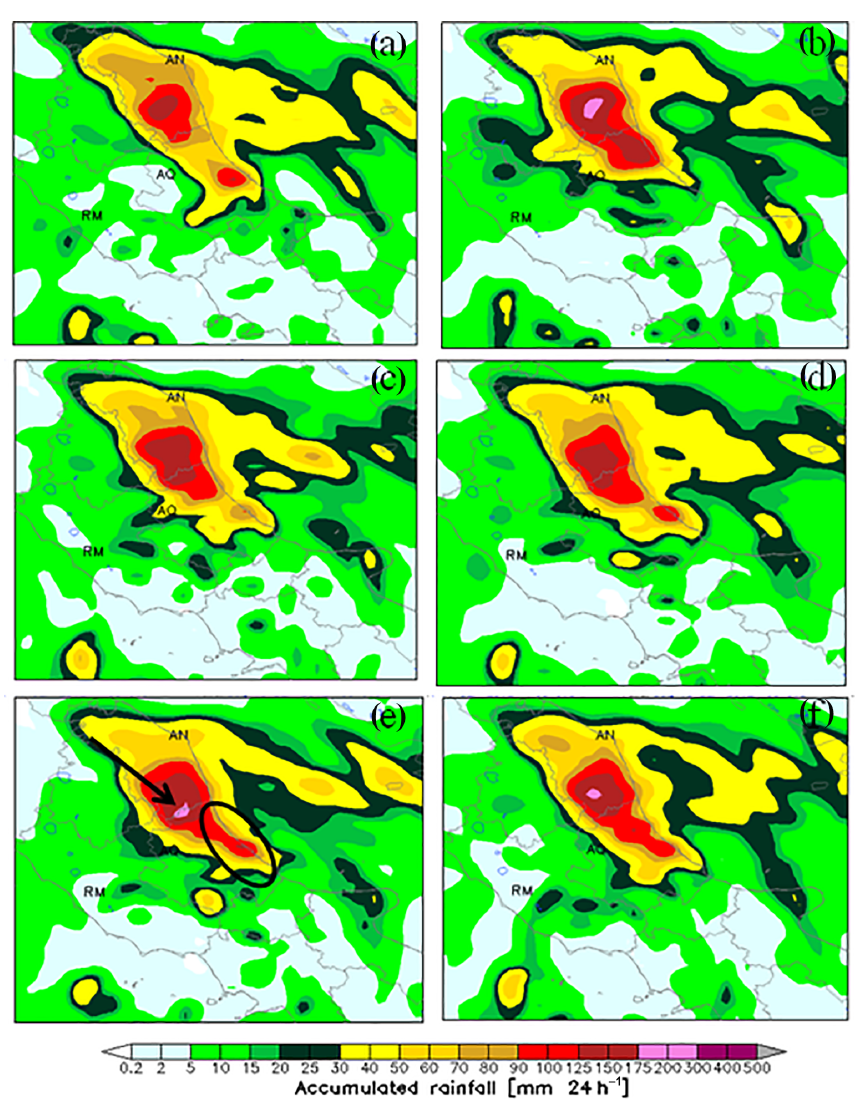
Figure 6. WRF D01 accumulated 24h rainfall forecast over central Italy from 00:00UTC on 14 September 2012: (a) WRF D01 CTL; (b) WRF D01 CON_LR_12KM; (c) WRF D01 CONMM_LR_12KM; (d) WRF D01 CONMMPOL_LR_12KM; (e) WRF D01 CON- MMPOLSPC_LR_12KM; (f) WRF D01